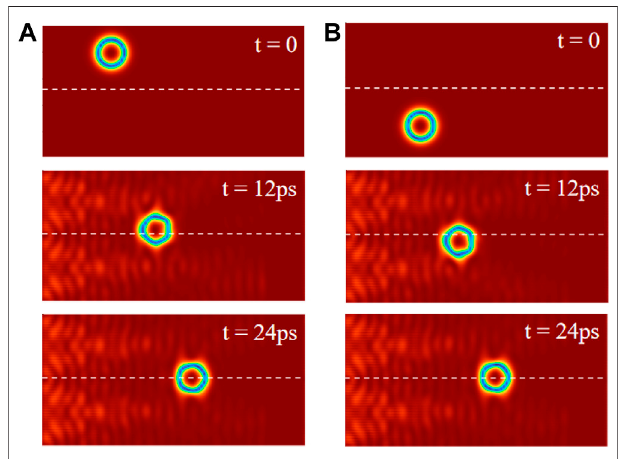
FIGURE 2 | The motion of the AFM skyrmion with different initial positions at (A) upside and (B) bottom side. The white dashed line indicates the intersection of the two spin wave